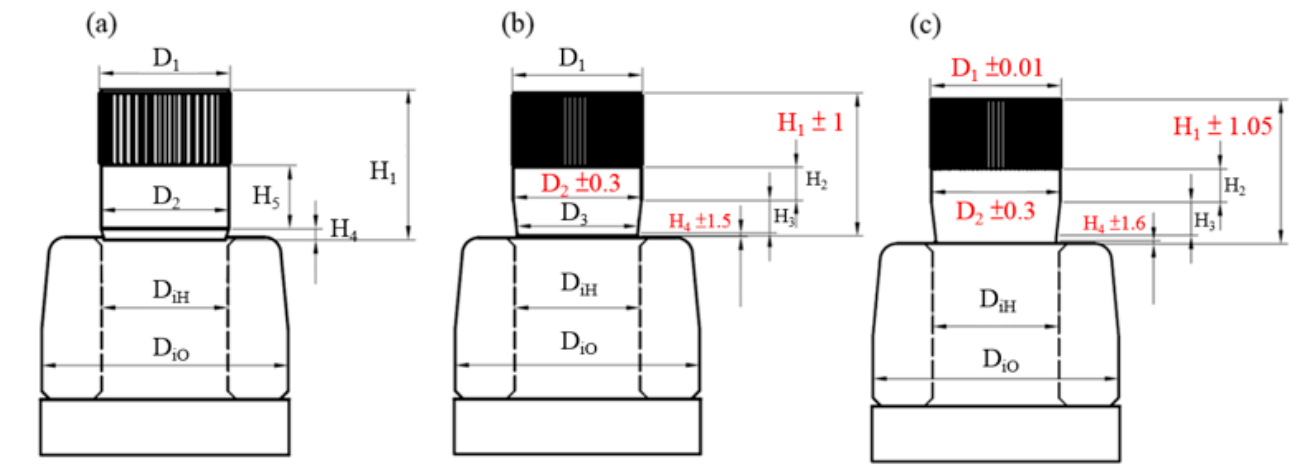
Figure 3. Different design versions of the shaft: ( a ) version 1, ( b ) version 2, and ( c ) version 3. The main structure examined in this study is shown in Figure 4. It included the shaft (punch) and the hub, and the driving force slowly pushes the shaft to get into the hub to connect these two parts of the structure during the jointing process. The contact region between knurled section and the inner hub was the most important observation position for the research. Moreover, the dimension of the knurled section was quite small (height 0.17 mm). It needs to mesh the connection region very evenly in the FE software. Thus, the mesh was refined to 0.01 mm both in the KIF region and hub. To build a dimensional sketch, SolidWorks software (SP 1.0, premium, Waltham, MA, USA) was used to make up the entire workpiece, such as forming the shape design, pattern sketch, inside and outside diameter of the hub, forming tolerance, etc.